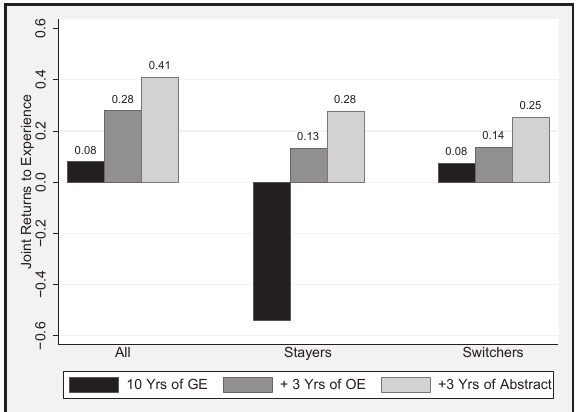
Figure 6 Joint returns to experience, excluding employment principals – two-digit level. Return to 10 years of GE and 0 years of OE and TE are not statistically signifi- cant at any of the conventional levels for the “All immigrants” and “Switchers” samples. Return to 10 years of GE and 0 years of OE and TE is significant at the 5% level for the “Stayers” sample. Returns to 10 years of GE, 3 years of OE, and no TE are significant at the 1% level for “All immigrants”. Return to 10 years of GE, 3 years of OE, and 0 years of TE is not significant at any of the conventional levels for the “Stayers” and “Switchers” samples. Return to 10 years of GE, 3 years of OE, and 3 years of Abstract TE is significant at the 1% level for the “All immi- grants” and “Switchers” samples. Returns to 10 years of GE, 3 years of OE, and 3 years of Abstract TE are not significant at any of the conventional significance levels for the “Stayers”